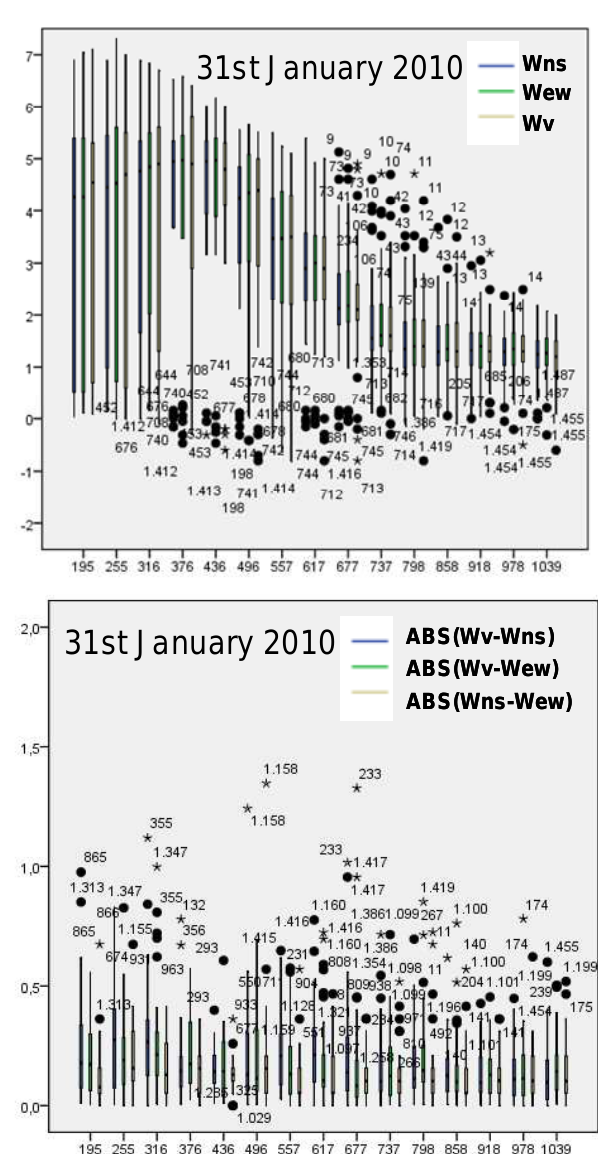
Fig. 15. Stratiform precipitation pattern: box plots on 31 January 2010. X axis (Height in meters above sea level). Y axis (Velocity in ms-1). Top panel, Vertical velocities versus height. Bottom panel, Absolute values of the differences between velocities versus height.